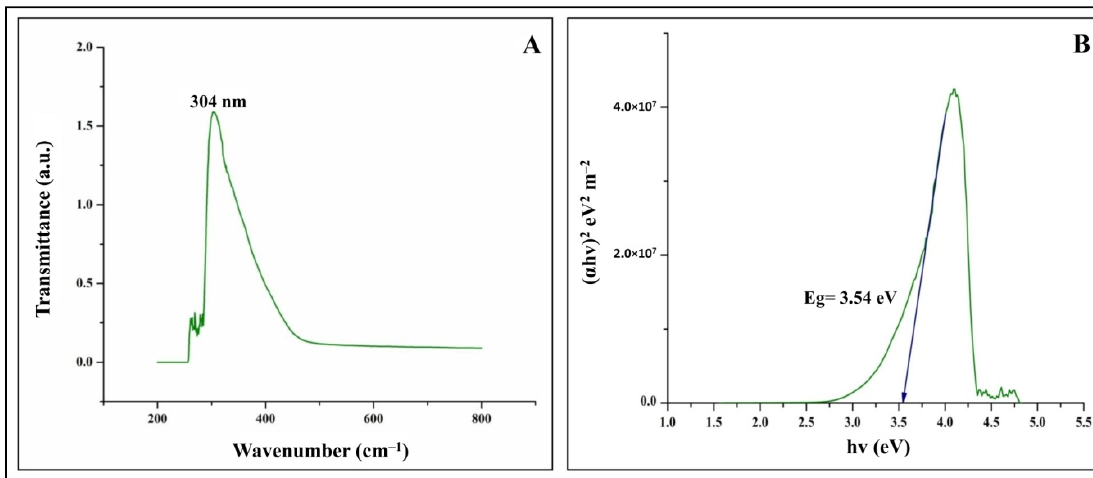
Figure 1. UV-visible absorption spectroscopy ( A ) and band gap energy ( B ) of phyto-fabricated zinc oxide nanoparticles (ZnO-NPs) from I. obscura aqueous leaf extract.